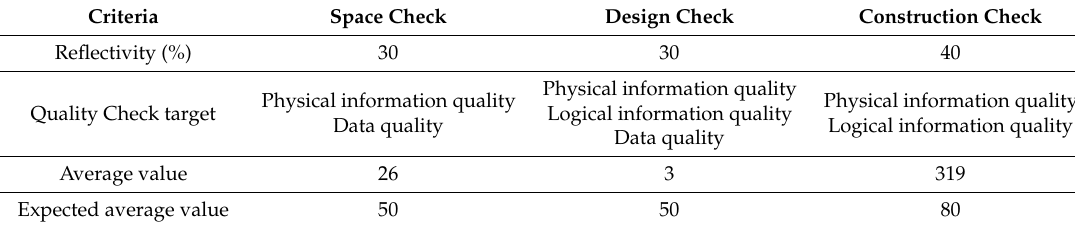
Table 15. The achievement score by criteria.